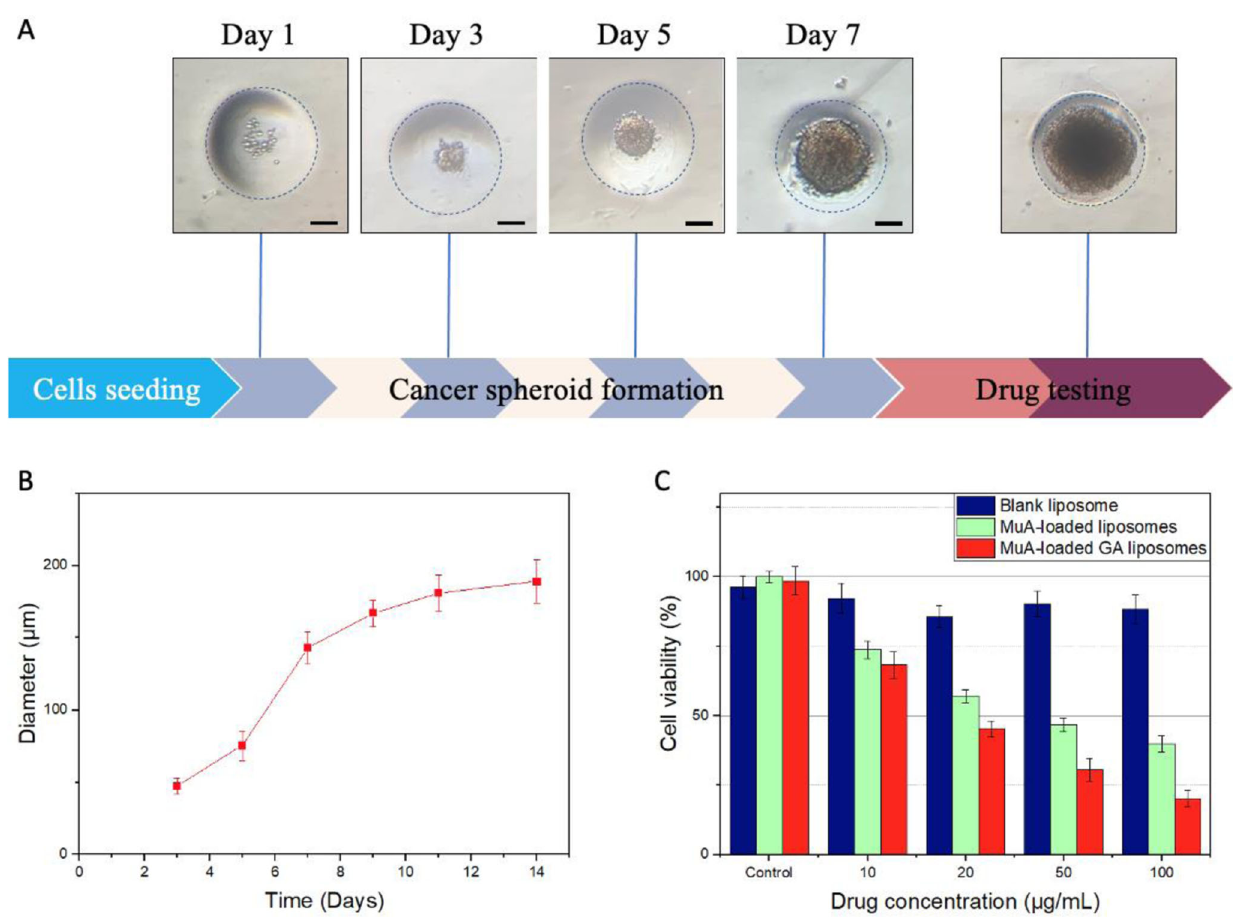
Fig. 6 Drug testing on 3D cancer spheroid platform. A Timeline formation of HepG2 cancer spheroids; ( B ) increase size of cancer spheroid. C Cell viability of. Data are presented as the mean ± SD ( n =